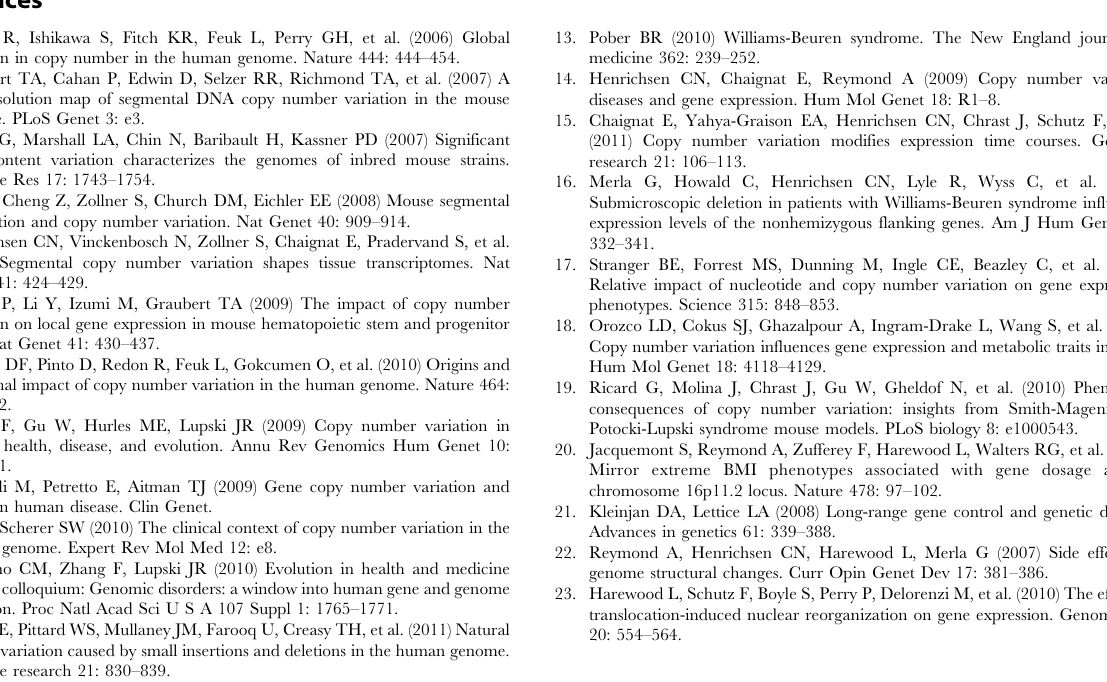
Figure S7 Examples of regions with modified interac- tions with the POR viewpoint. The y-axis represents postprocessed normalized counts. The log2-fold change of the windowed 4C data in WBS over Ctrl cells is plotted. Positive or negative Bricks are indicated below each viewpoint graph, by blue or red bars, respectively. In WBS cells, the region around the CDK6 gene ( A ) or sonic hedgehog ( SHH gene) ( B ) interacts with the POR gene, whereas in Ctrl cells, the flanking regions interact more frequently, indicating local changes in interactions. (PDF) Table S1 4C-seq primer sequences. (PDF) Table S2 Overview of the location of Bricks per viewpoint for control and WBS cells, as well as the ratio. (PDF) Table S3 Correlation analyses between six different marks of regulatory elements and interacting regions in Ctrl cells (Ctrl Bricks), in all differential interacting regions significantly decreased (negative ratio Bricks) or increased (positive ratio Bricks) in WBS versus Ctrl cells. Permutation test with number of permutation = 1000. Significant p-values are highlighted in grey.